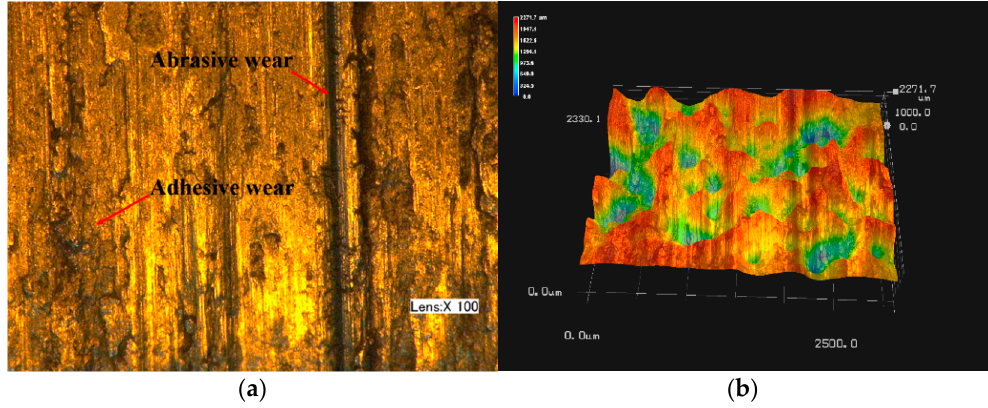
Figure 9. Micrographs of the second specimen: ( a ) 2D micrographs; ( b ) 3D micrographs.